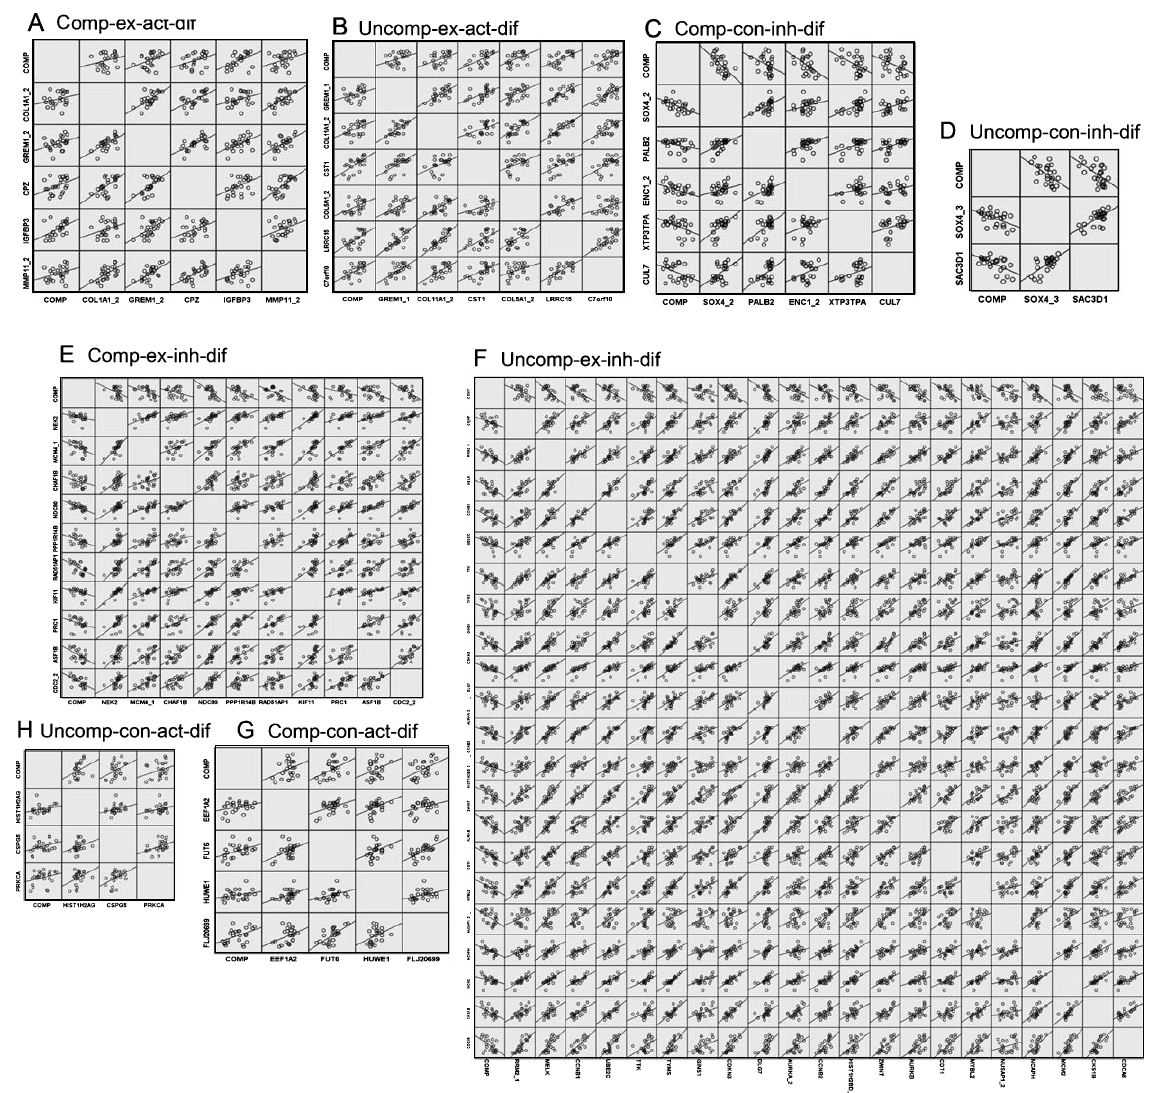
Fig. 2. The mutual relationships of novel different COMP -activated and -inhibited networks by scatterplot (matrix) and our programming. (A) Complete (all no positive correlation, Pearson CC<0.25) and (B) uncomplete (partly no positive correlation except COMP , Pearson CC<0.25)differentmutualrelationshipsof COMP -activatednetworkinhigherlungadenocarcinomacomparedwithlowerexpressionofhuman normal adjacent tissues by scatterplot (matrix) and our programming, respectively. n =25. (C) Complete and (D) uncomplete different mutual relationships of COMP -inhibited network in lower human normal adjacent tissues compared with higher lung adenocarcinoma by scatterplot (matrix)andourprogramming,respectively. n =25.(E)Completeand(F)uncompletedifferentmutualrelationshipsof COMP -inhibitednetwork in higher lung adenocarcinoma compared with lower expression of human normal adjacent tissues by scatterplot (matrix) and our programming, respectively. n =25. (G) Complete and (H) uncomplete different mutual relationships of COMP -activated network in lower expression of human normal adjacent tissues compared with higher lung adenocarcinoma by scatterplot (matrix) and our programming, respectively. n =25. Comp, complete; Uncomp, uncomplete; con, human normal adjacent tissues; ex, lung adenocarcinoma; act, activation; inh, inhibition; dif,